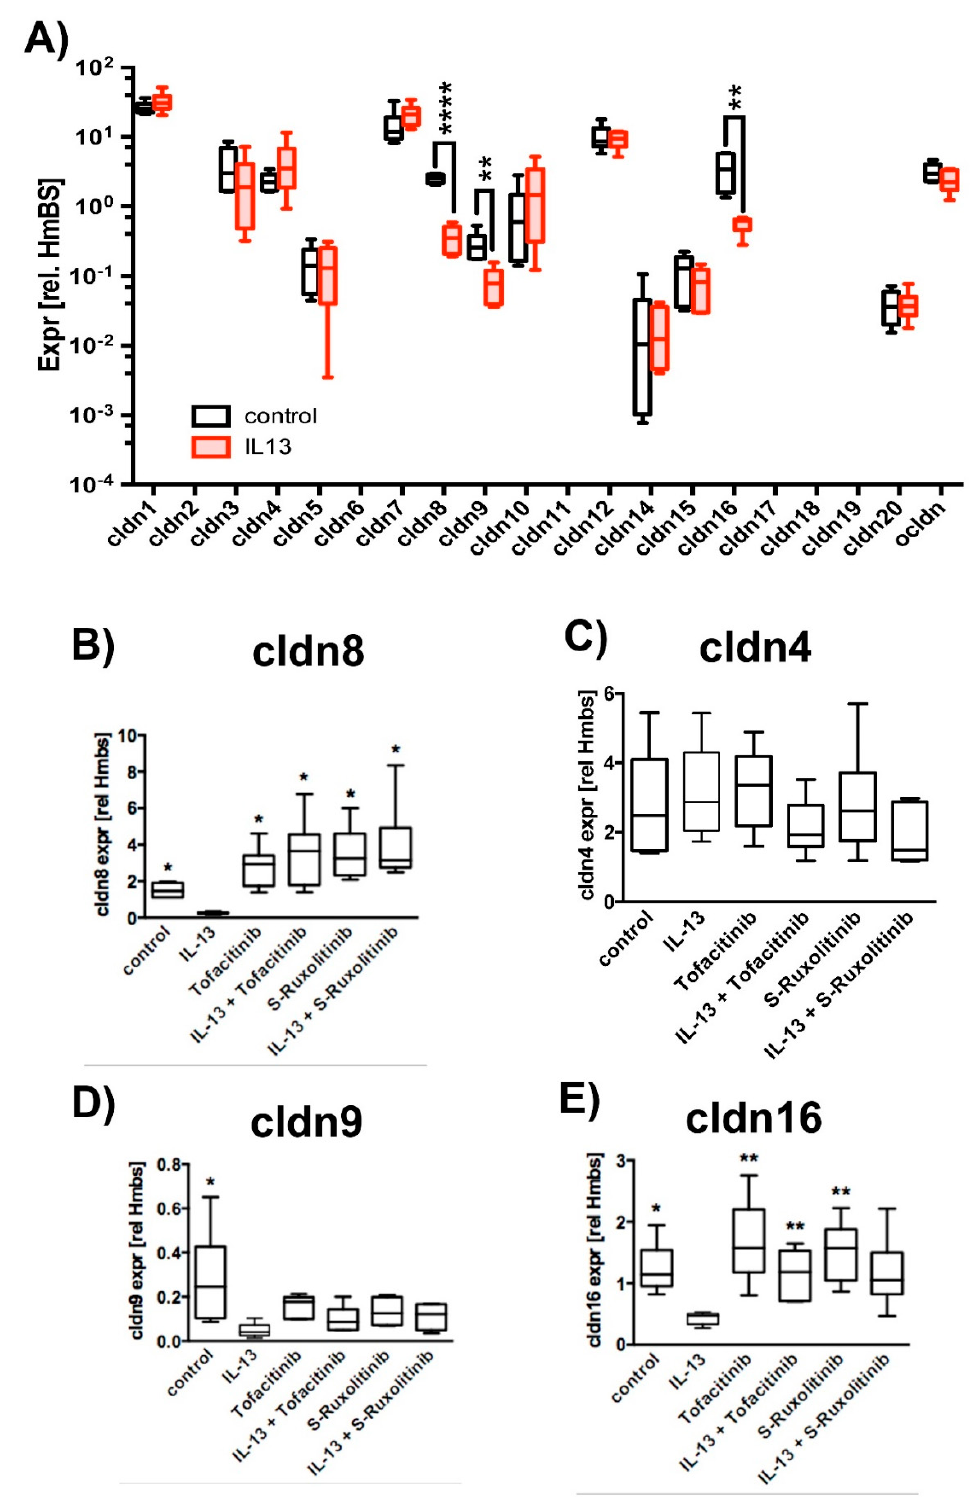
Figure 2. Effect of IL-13 on claudin and occludin expression levels. Human tracheal epithelial cells were cultivated at air-liquid interface conditions. Expression levels were normalized to HmBS. The box plot summarizes data as median values, the boxes represent percentiles, the whiskers indicate minimum/maximum. ( A ) Claudin expression levels in epithelia cultivated in the absence (control) or presence of 10 ng/mL IL-13 (IL-13). Multiple T -test, all IL-13 versus control, cldn8 p < 0.0001, cldn9 p = 0.005 and cldn16 p = 0.005, N = 6). Transcripts encoding claudins 2, 6, 11, 17, 18 and 19 were not detected. Changes in cldn expression levels were confirmed and the effect of inhibition of JAK/STAT pathway was tested in subsequent independent experiments (control epithelia = control, epithelia